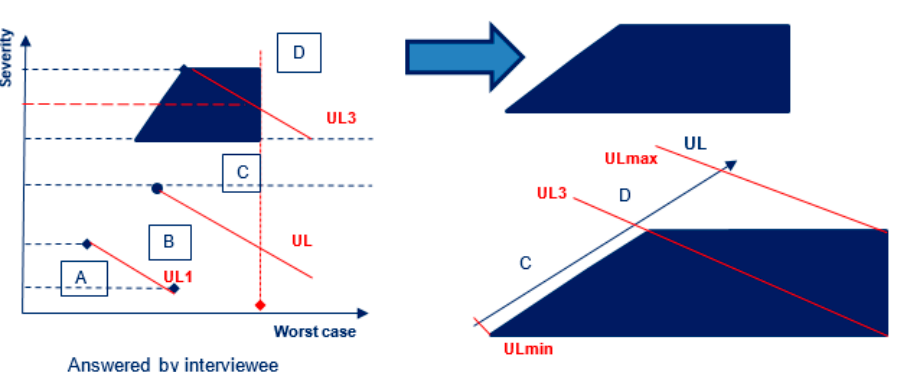
Figure 7. OpRSA Method. Output: Unexpected Loss (UL). Source: author own study.